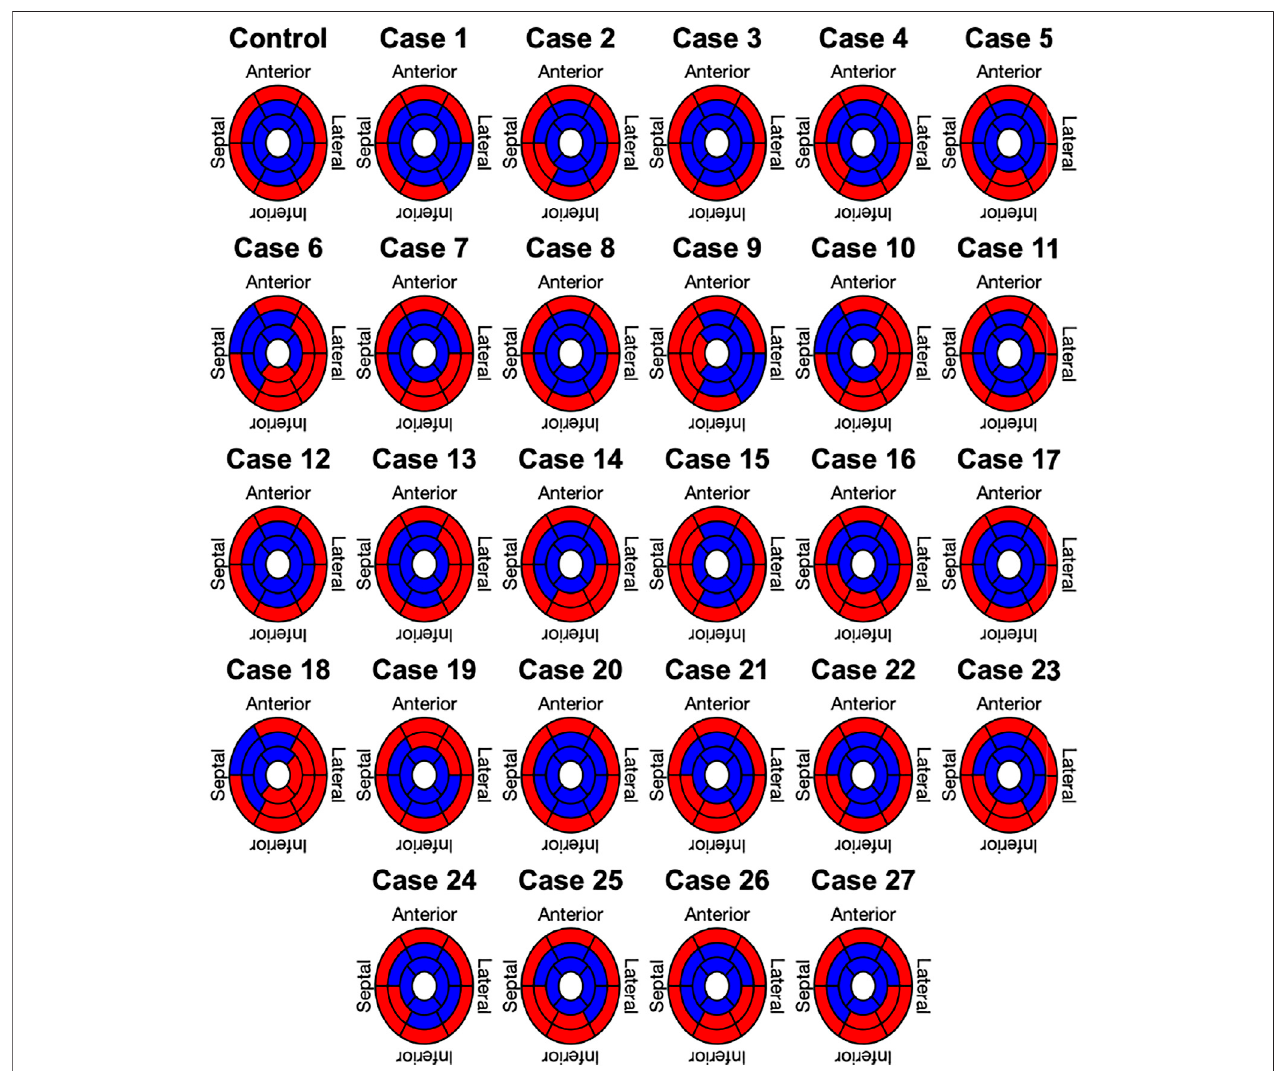
FIGURE 7 | Segment based analysis of end-systolic rotation around the long axis of the LV. A binary classi fi cation was used in each segment to determine clockwise (red) or counterclockwise (blue) rotation.